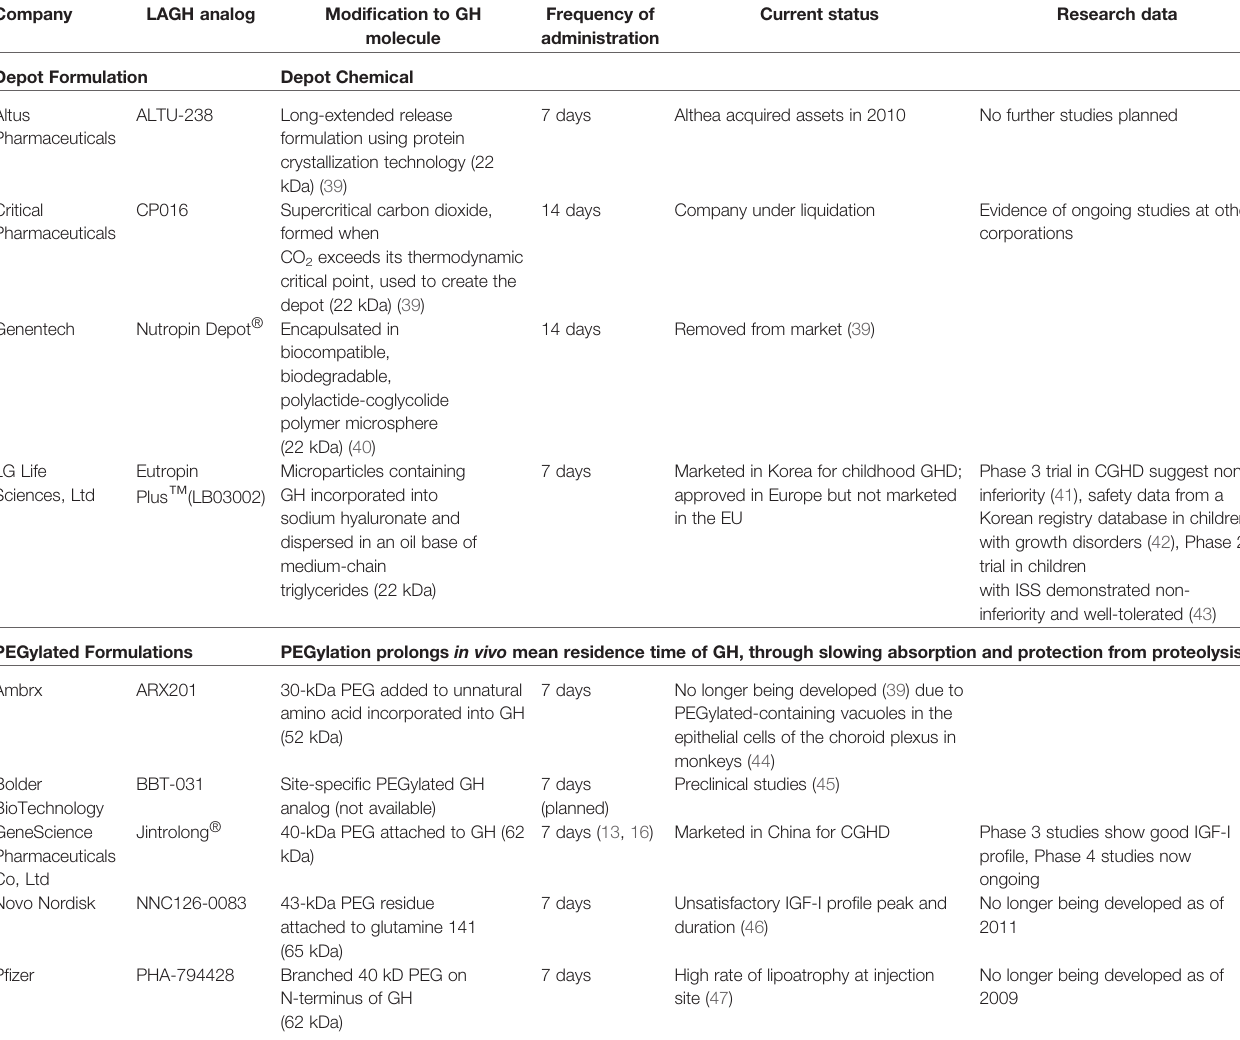
TABLE 1 | Overview of the development history of LAGH